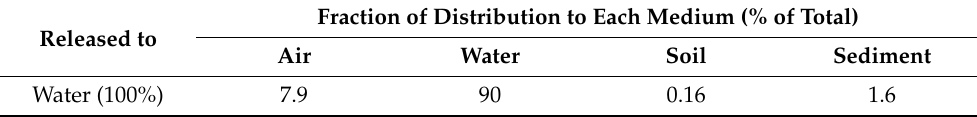
Table 3. Estimated distribution of benzyl chloride after its release in water.